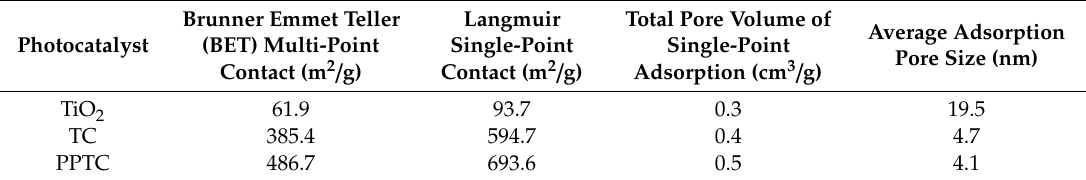
Table 1. Specific surface area of TiO 2 , TC, and PPTC.